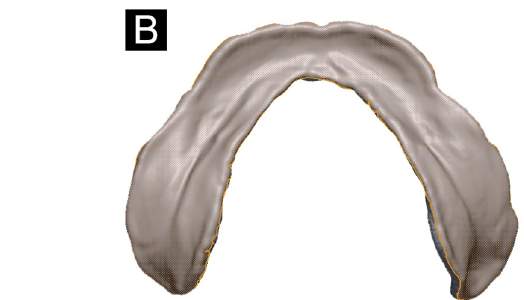
Figure 2. Design of the maxillary ( A ) and mandibular ( B ) denture bases. The inner area of the denture base was selected to evaluate accuracy.